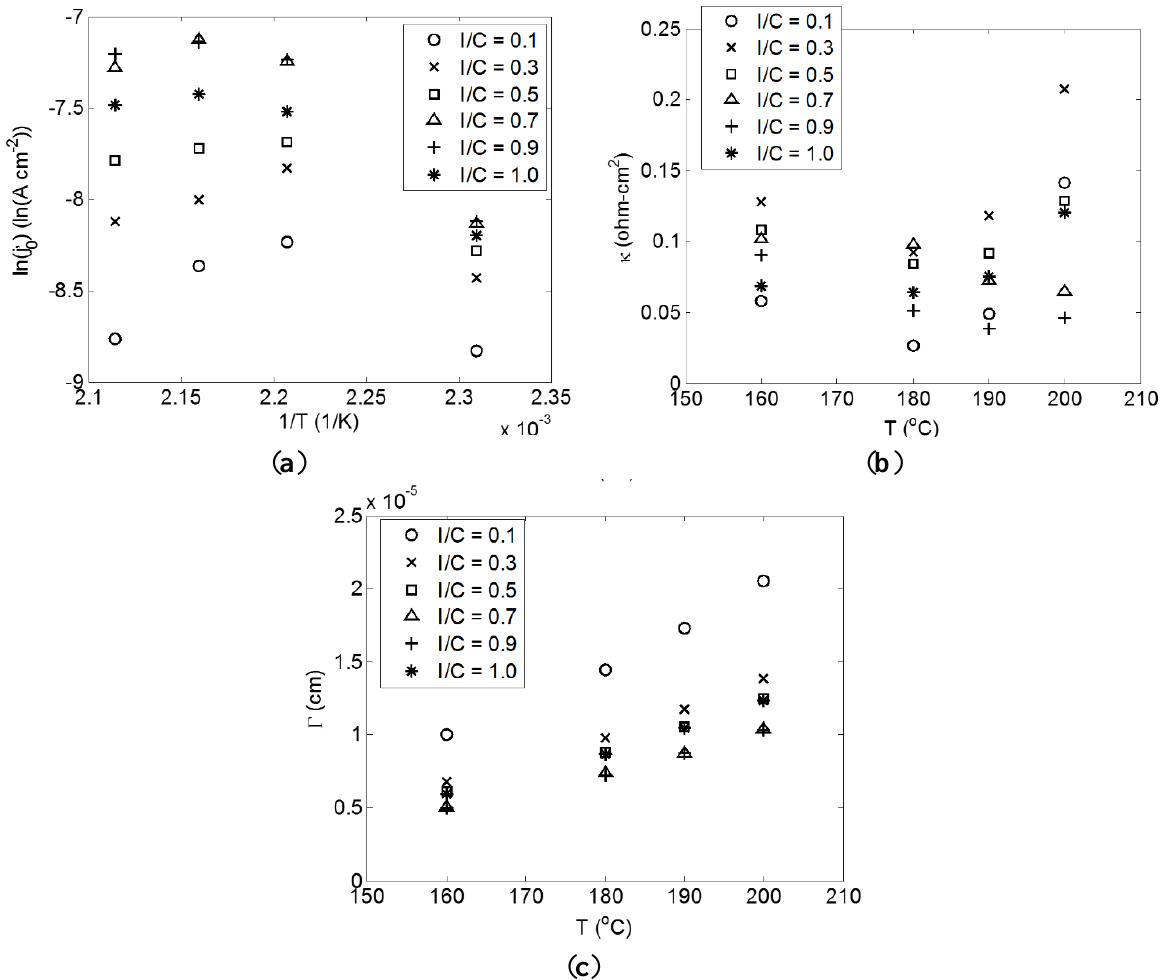
j ′ , ( b ) represents the area specific 0,c